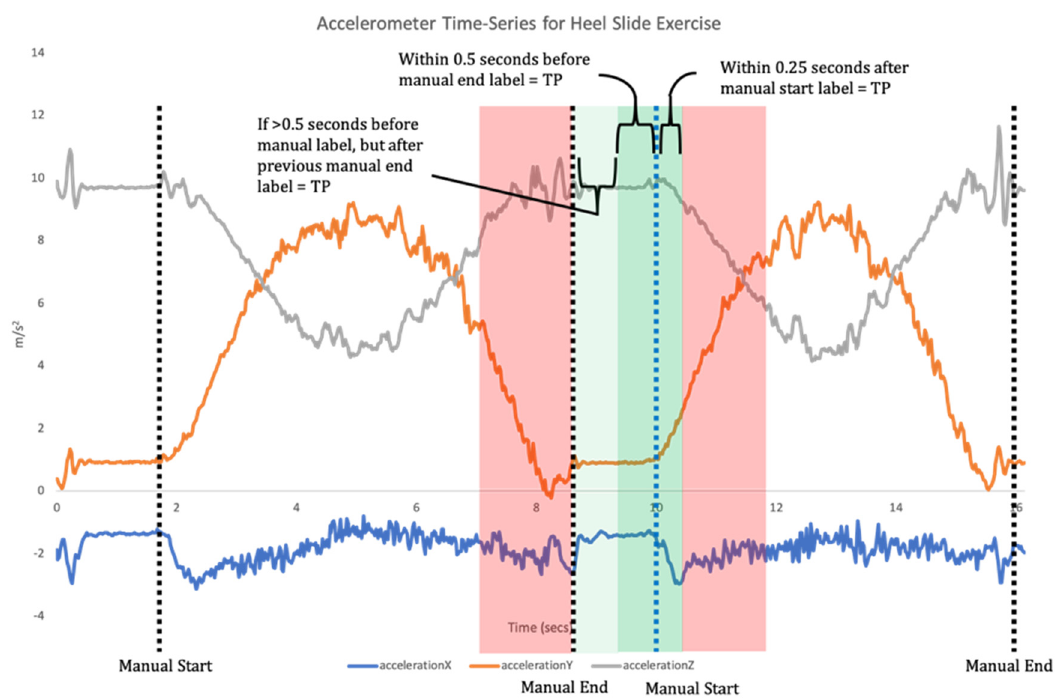
Figure 5. Illustration of threshold for segmentation for points identified as the start of a repetition. The manual annotation for reference is highlighted in blue and the area for TP in green. The opposite was used for the predicted points at the end of a repetition, where the threshold was 0.25 s before to 0.5 s after the manually annotated point, with a point greater than 0.5 s after the corresponding manual point but before the manually selected point for the start of the next repetition also being identified as a TP (Figure 6).